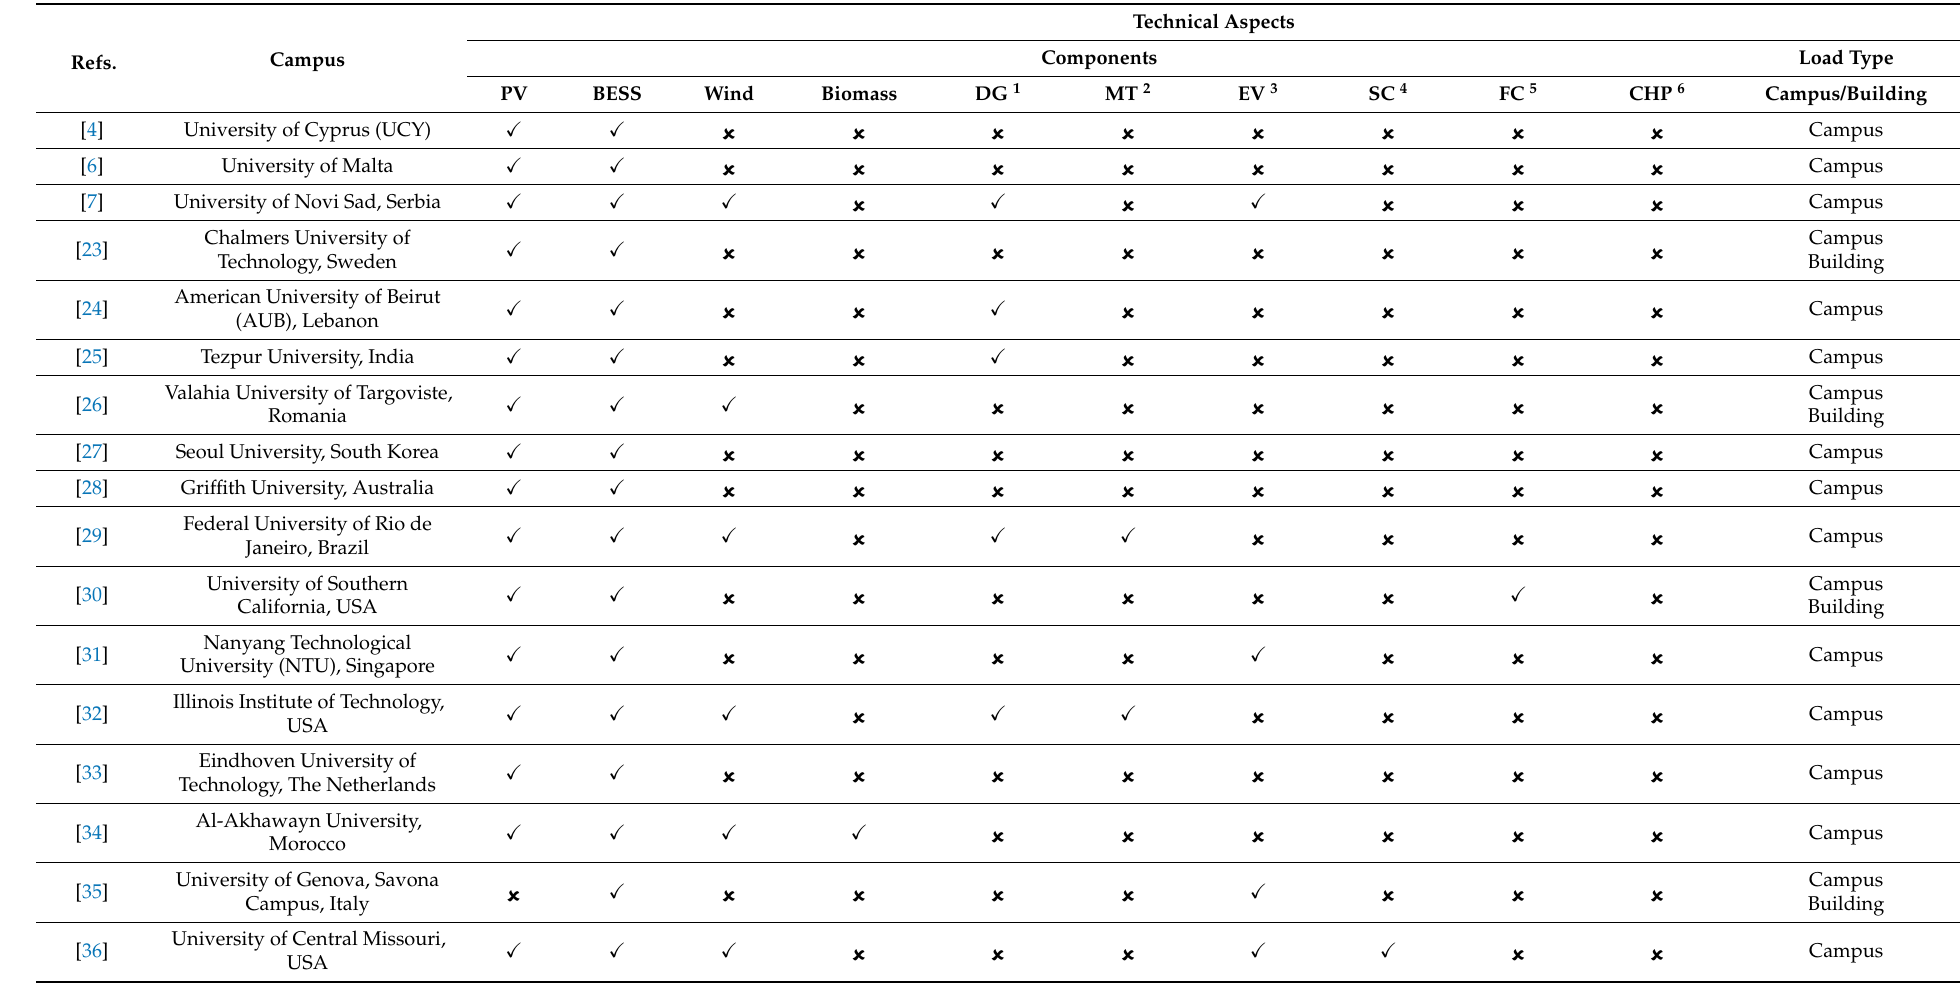
Table 1. A review of the literature of campus microgrids with multiple sites.